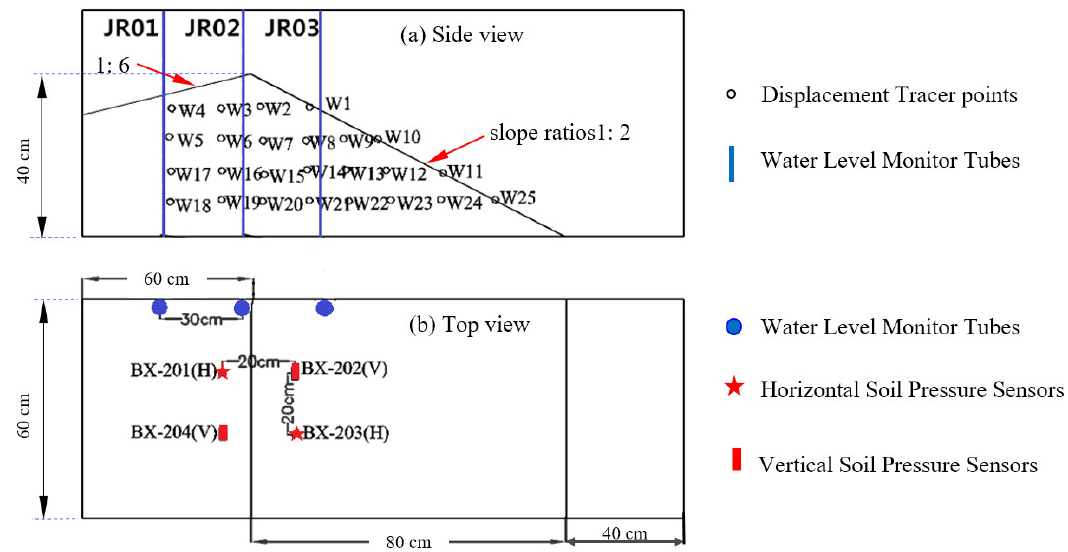
Figure 2. Monitoring distribution of tailings dam failure experiment. ( a ) Side view; ( b ) Top view. Table 1. Basic property of